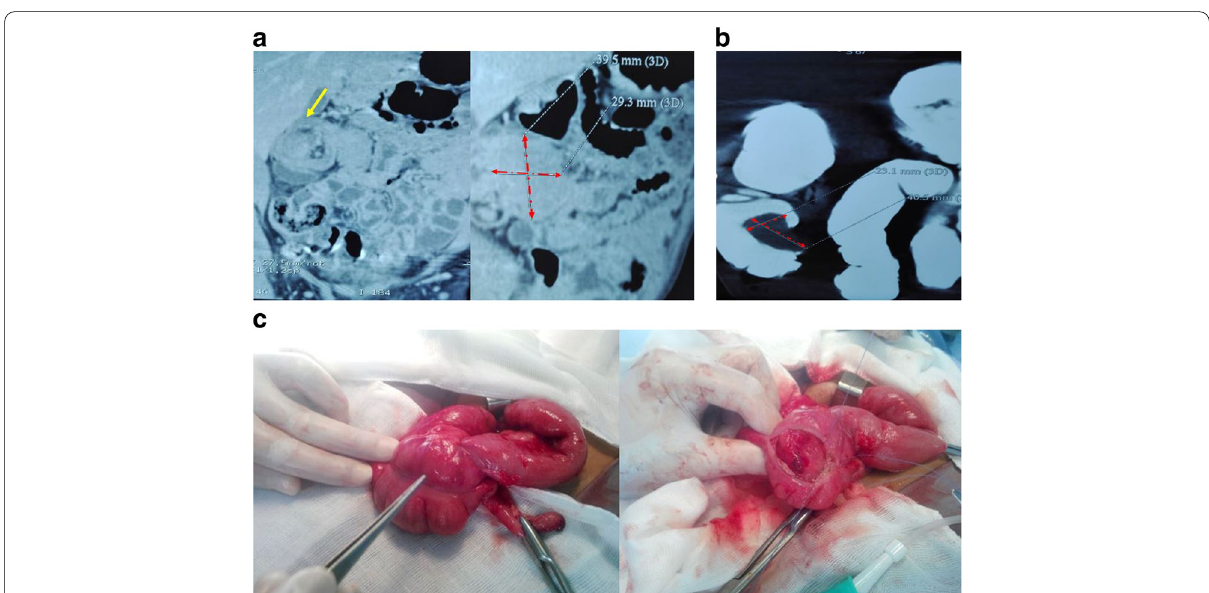
Fig. 2 a Abdominal CT scan showing ileocolic intussusception (yellow arrow), with a complex mass (red arrows) in the right lower abdomen that appears to arise from the wall of the caecum. b Barium enema showing a focal filling defect at the caecum wall (red arrow). c Intraoperative view of caeca mass associating with ileocolic